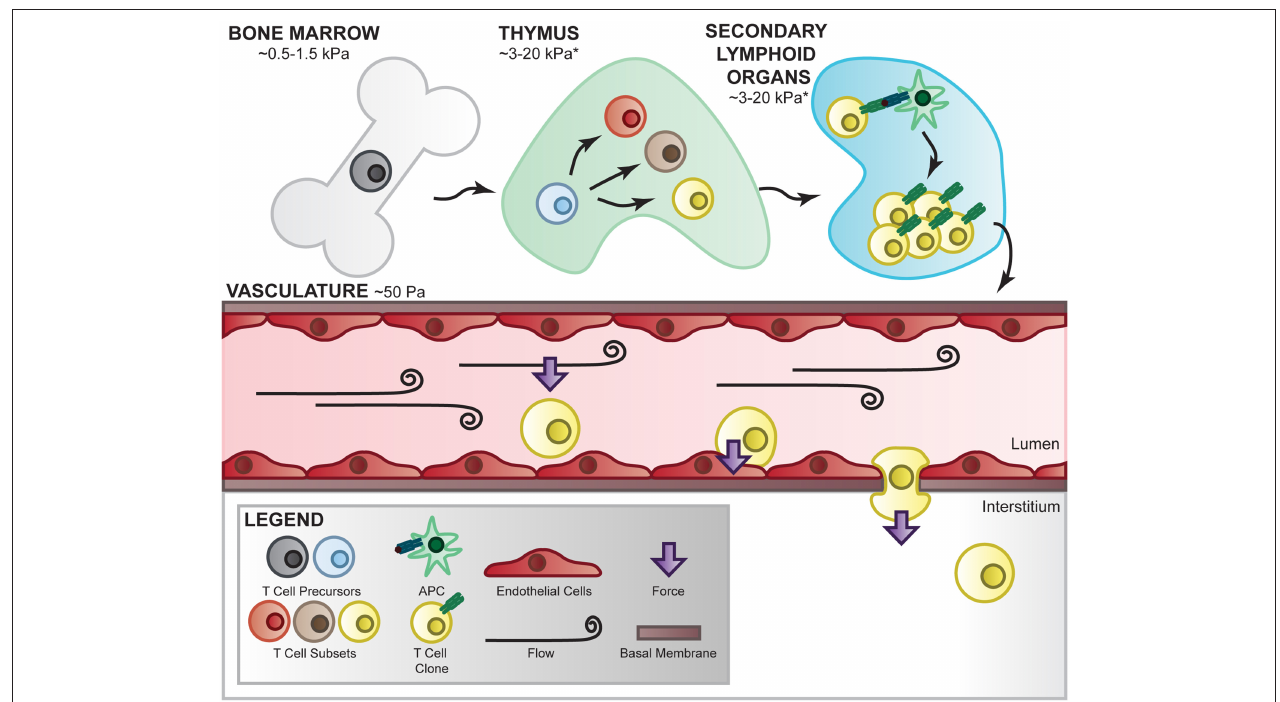
FIGURE 2 | T-cell mechanical environment. T cells are subjected to various mechanical environments throughout their lifetime. During development and differentiation, T cells migrate between tissues of varying elasticity and extracellular matrix components which has been shown to affect their signaling and differentiation [130–132]. In the periphery, they are subjected to fluid flow-mediated forces which apply shear stress to the cells and their receptor/ligand interactions. In this environment, T cells are able to crawl along the vascular bed, adhere at the correct location, deform their shape, and propel themselves into the interstitial space to perform their immune function, all of which requires internally generated force as well as external mechanical regulation [133, 134]. *Estimation based on measured Young’s modulus on similar organs [